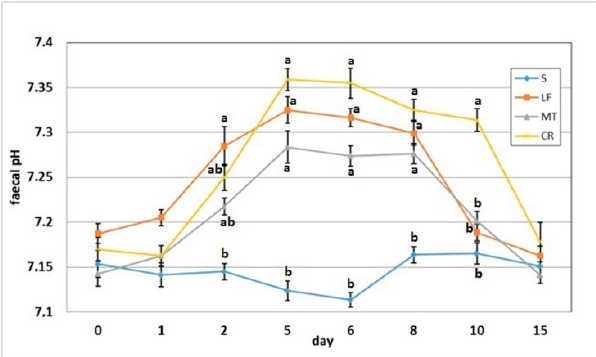
Figure 6. Faecal pH of rats fed diets supplemented with lactoferrin, melittin or cecropin A. Experi- mental factor in particular groups: S—control standard diet (0–15 days); LF—standard diet with lactoferrin addition 100 mg/kg (0–5 days diet LF and 6–15 days diet S); MT—standard diet with melittin addition 100 mg/kg (0–5 days diet MT and 6–15 days diet S); CR—standard diet with cecropin A addition 100 mg/kg (0–5 days diet CR and 6–15 days diet S). a,b Mean values on the day with no common superscript are different at p ≤ 0.05. Data are presented as the mean with SEM; SEM—SD for all rats divided by the square root of rat number in one group ( n = 8).